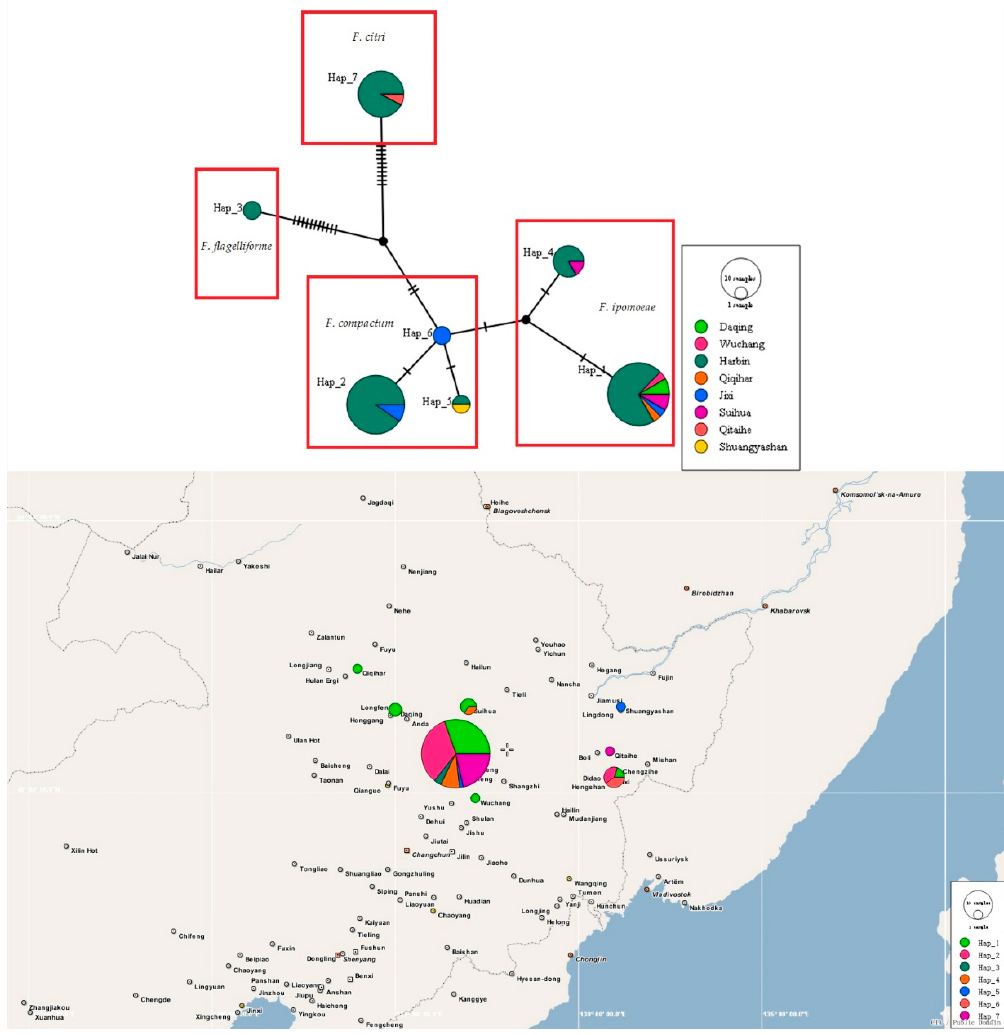
Figure 7 . TCS analyses and the haplotype distribution based on the tef1 gene sequences of 70 FIESC isolates obtained in this study. Each haplotype is represented by a circle, the size of which is proportional to the haplotype frequency.